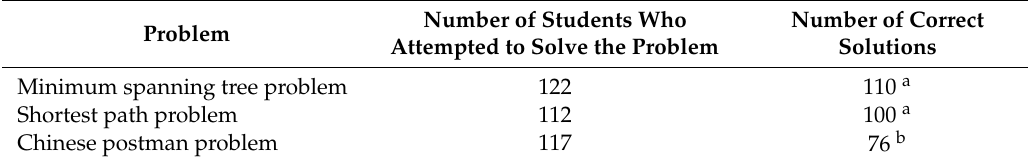
Table 2. Success rates of analyzed problems (source: own calculation).